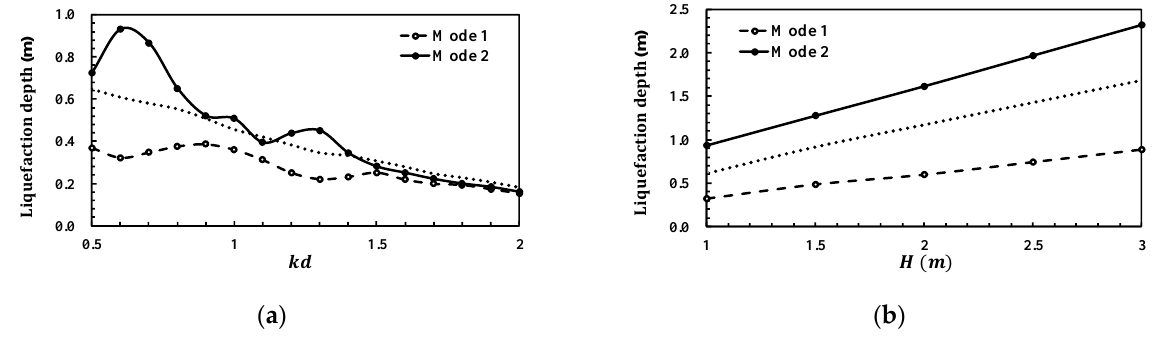
Figure 26. Effect of the wave characteristics on the liquefaction depth around the vertical breakwater. The dotted line is the liquefaction depth under the rigid breakwater condition, only. ( a ) wave period 𝑘𝑑 ; ( b ) wave height 𝐻 .